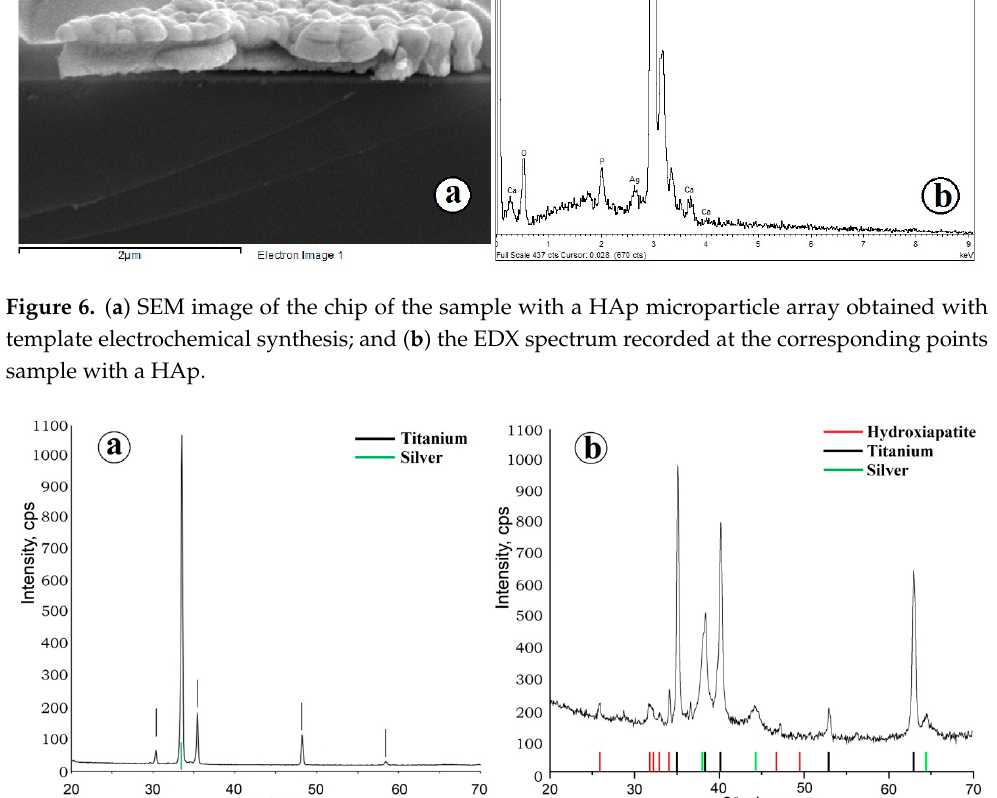
Figure 7. XRD patterns of the composite coating TiO 2 /Ag/HAp.